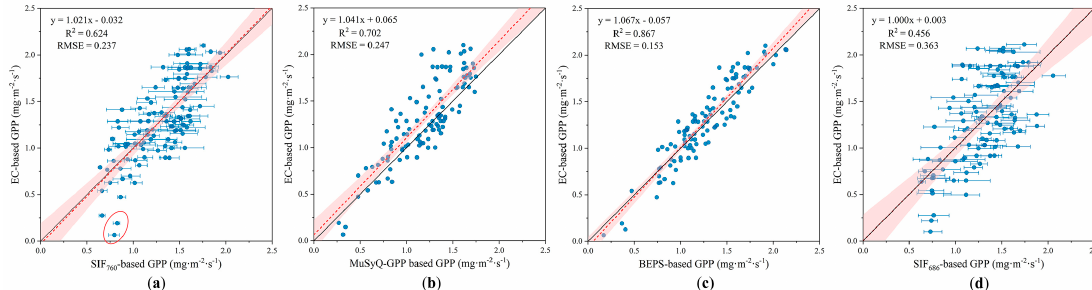
Figure 6. Relationships between modeled GPP and EC-based GPP by: ( a ) SIF 760 ; ( b ) MuSyQ-GPP; ( c ) BEPS; and ( d ) SIF 686 during the experiment period. The dots in the red circle are the values at 8:30 on 21 August, and 8:30 on 22 August. The error bars indicate the range of the four SIF-based GPP values, the red shades represent the 95% confidence bands for the regression functions.